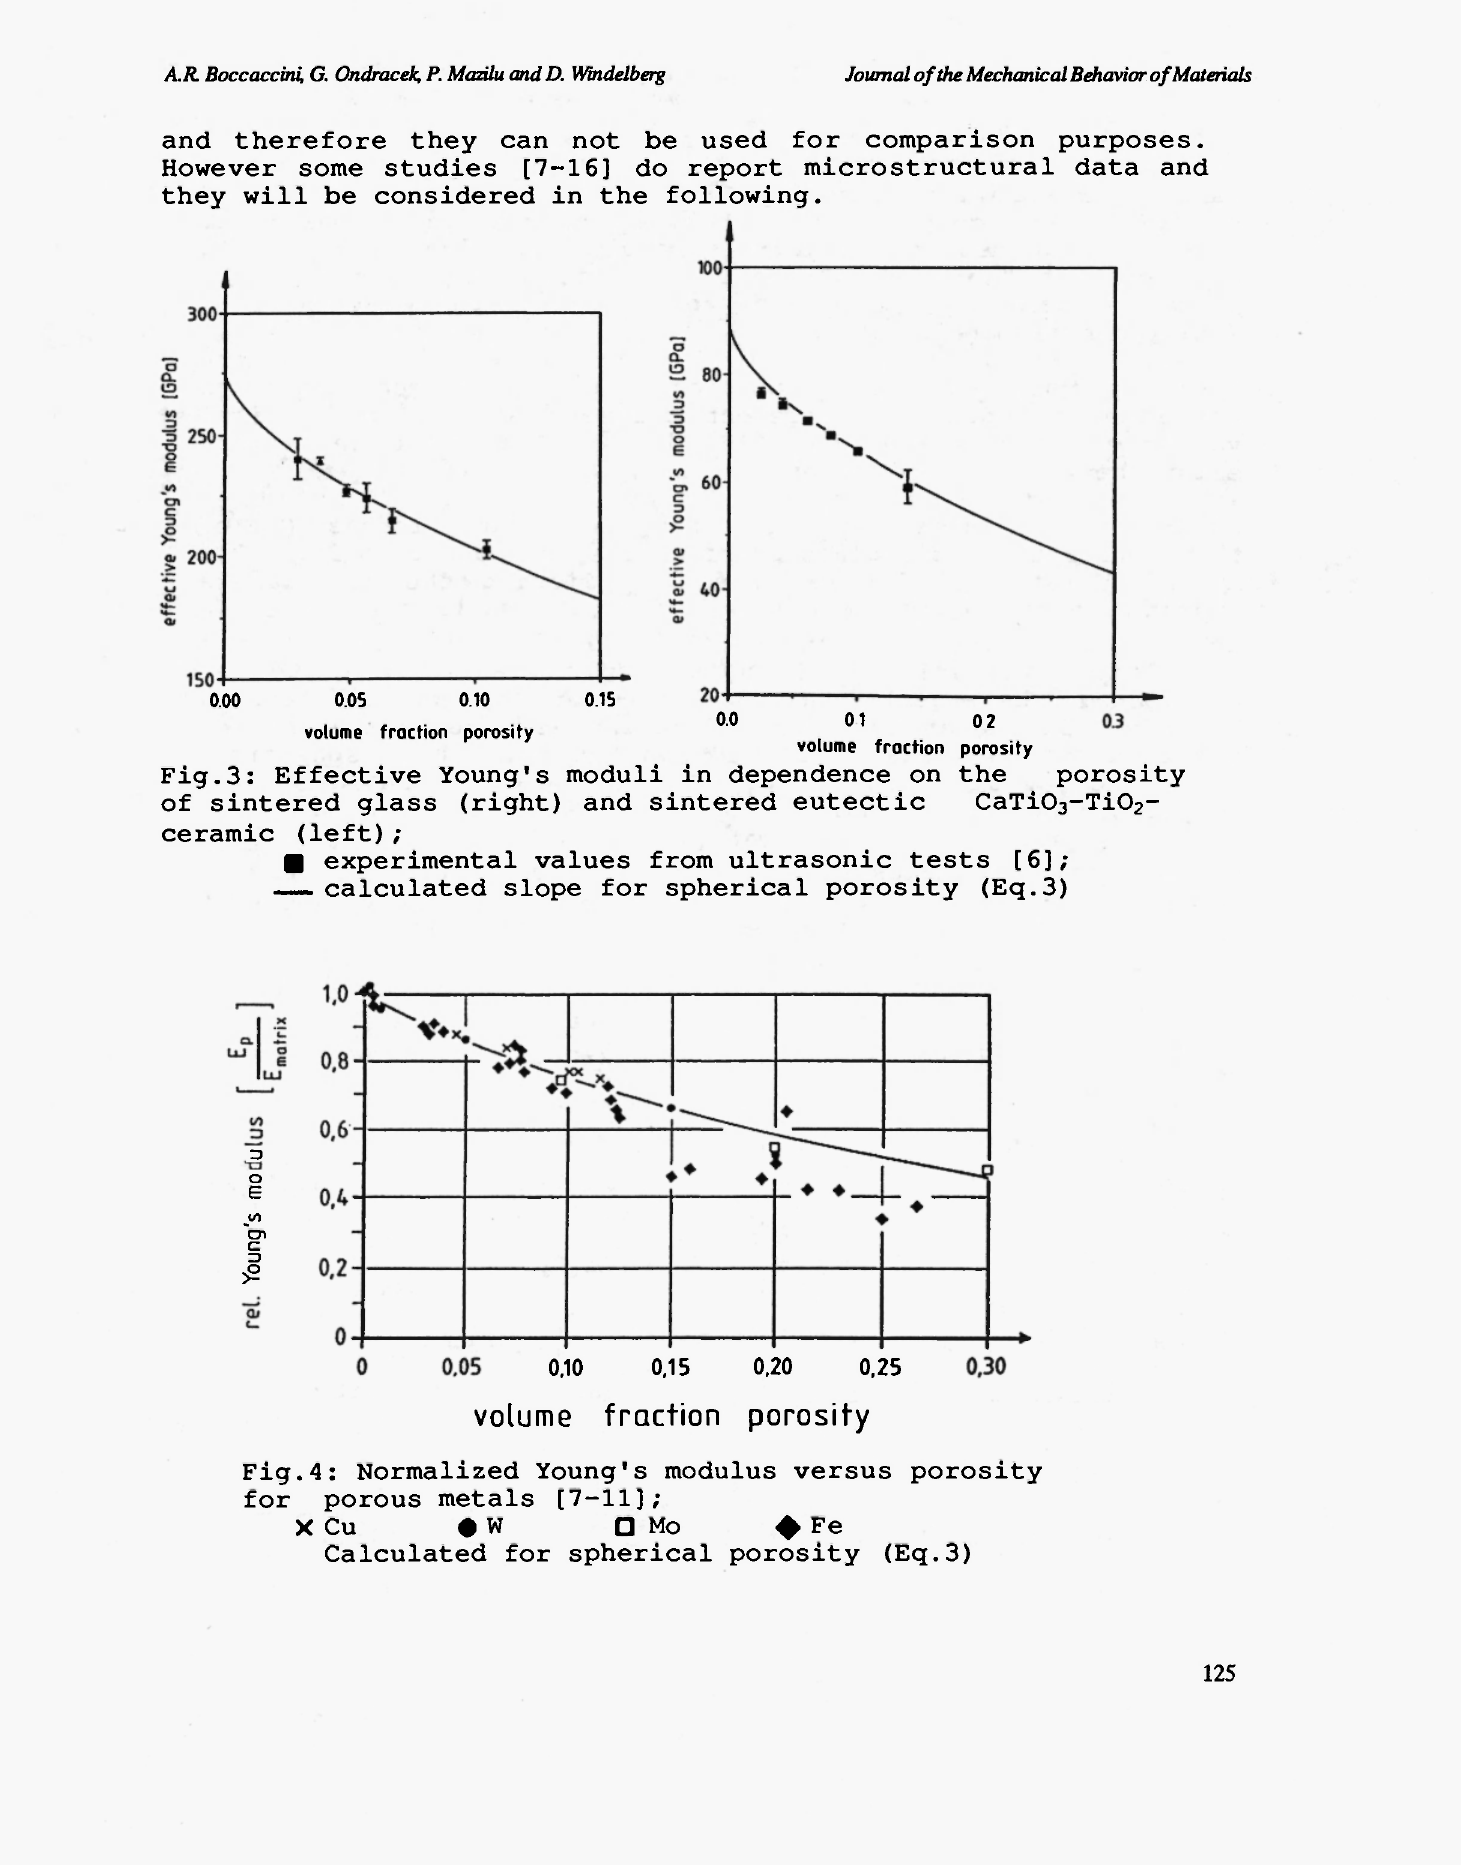
Fig.3: Effective Young's moduli in dependence on the of sintered glass (right) and sintered eutectic ceramic (left);